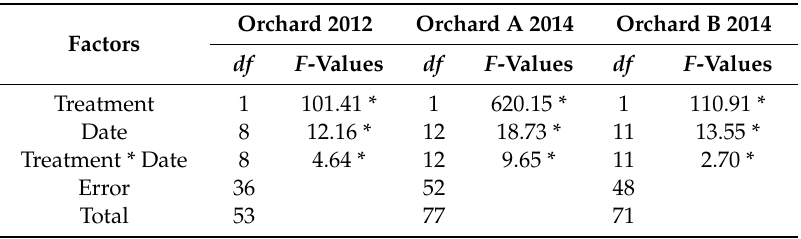
Figure 1. Trend of Grapholita funebrana males catches per trap per week in ( A ) Orchard 2012, ( B ) Orchard A 2014 and ( C ) Orchard B 2014. The mean number of captures per trap over the entire study period is reported in the legend; different letters indicate significant differences between the means (GLM followed by Tukey’s HSD test, p < 0.05). Table 1. Results of the general linear model (GLM) analyses, performed each year separately on the number of Grepholita funebrana males caught in the traps, and e ff ect of the di ff erent factors considered (asterisks indicate significant factors within each year, * p <